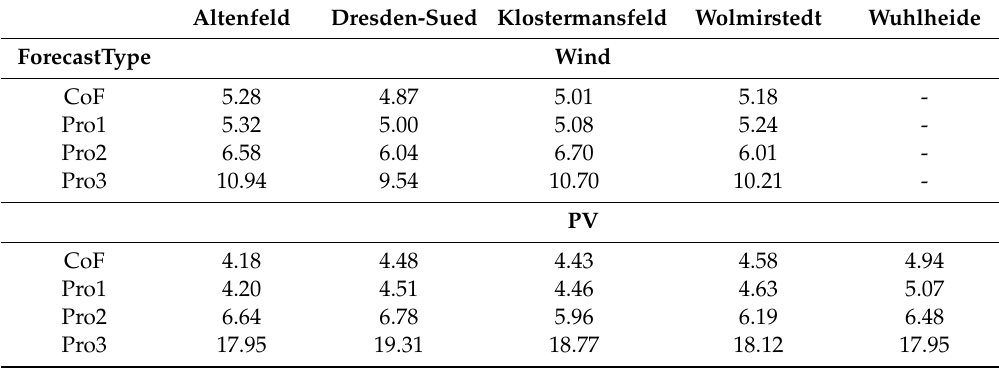
Table 5. Forecast accuracies of substation-specific wind and photovoltaic (PV) generation forecasts: RMSE in %.